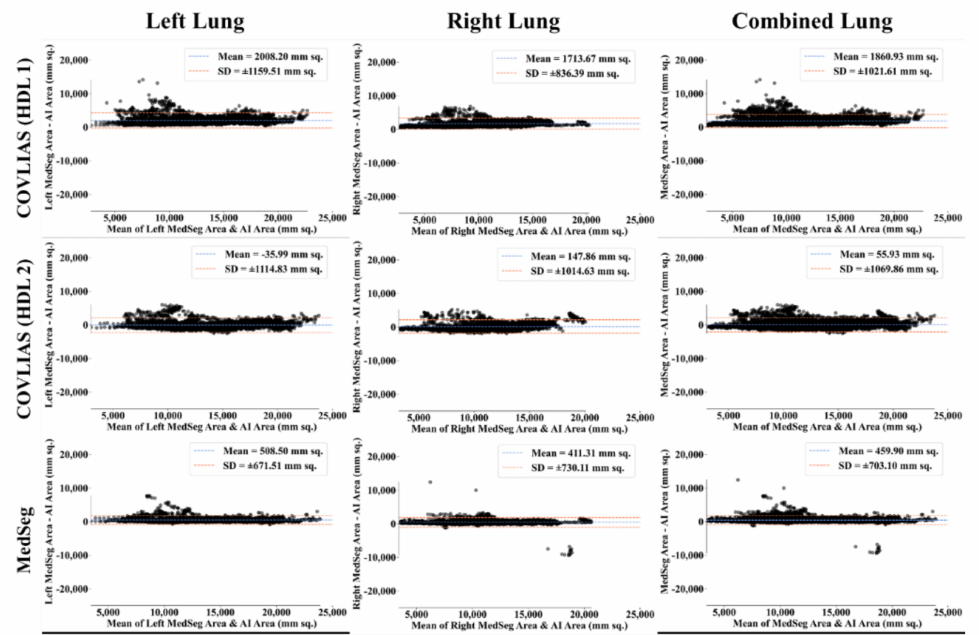
Figure 12. Bland–Altman plots: COVLIAS (row 1 and row 2) vs. MedSeg (row 3) using MD 2. Column 1: left lung, column 2: right lung, and column 3: mean of left and right. COVLIAS (HDL 1): VGG-SegNet; COVLIAS (HDL 2): ResNet-SegNet.